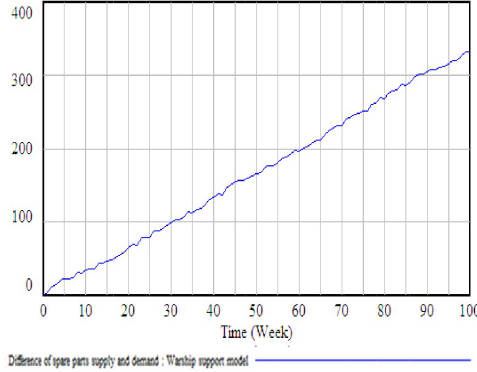
Figure 5. Inventory of warship carrying spare parts Figure 6. Demand of warship spare parts